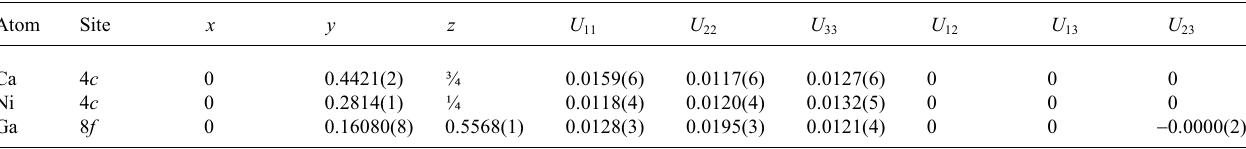
Table 2. Atomic coordinates and displacement parameters (in Å 2